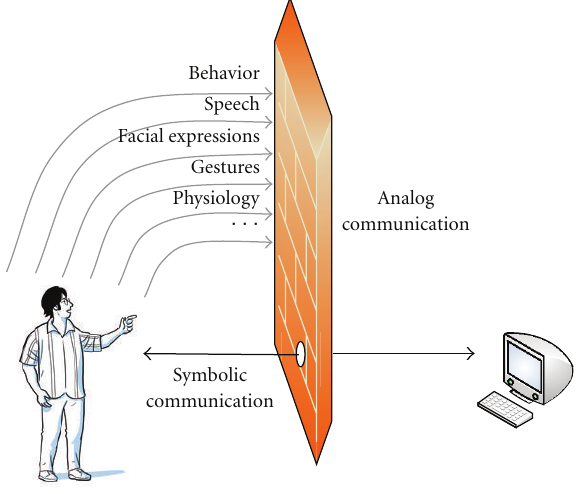
Figure 1: Typical human-computer interaction by symbolic encod- ing. Analog channels are not seen by the